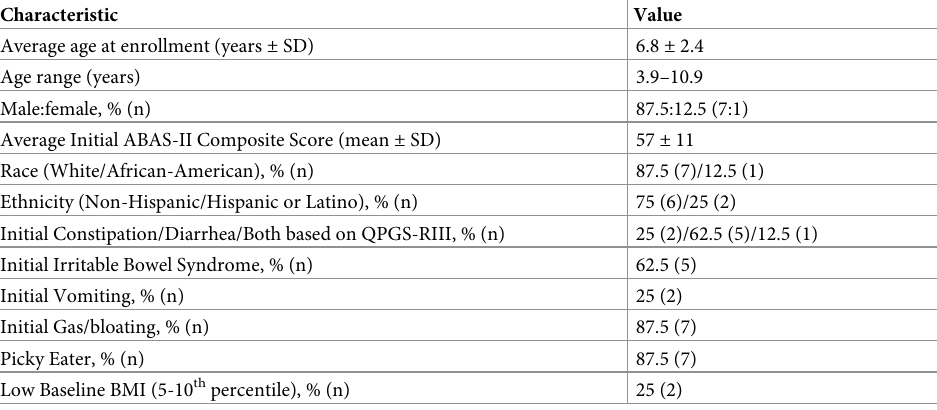
Table 1. Participant demographics at baseline.